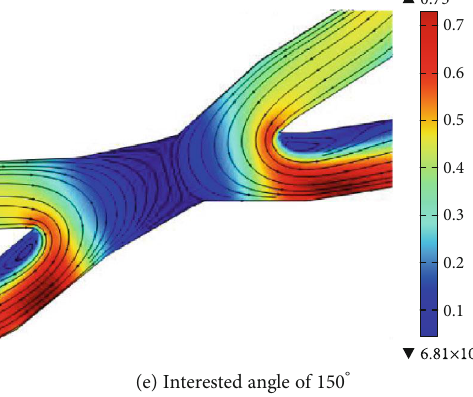
Figure 21: Velocity distribution of specimen